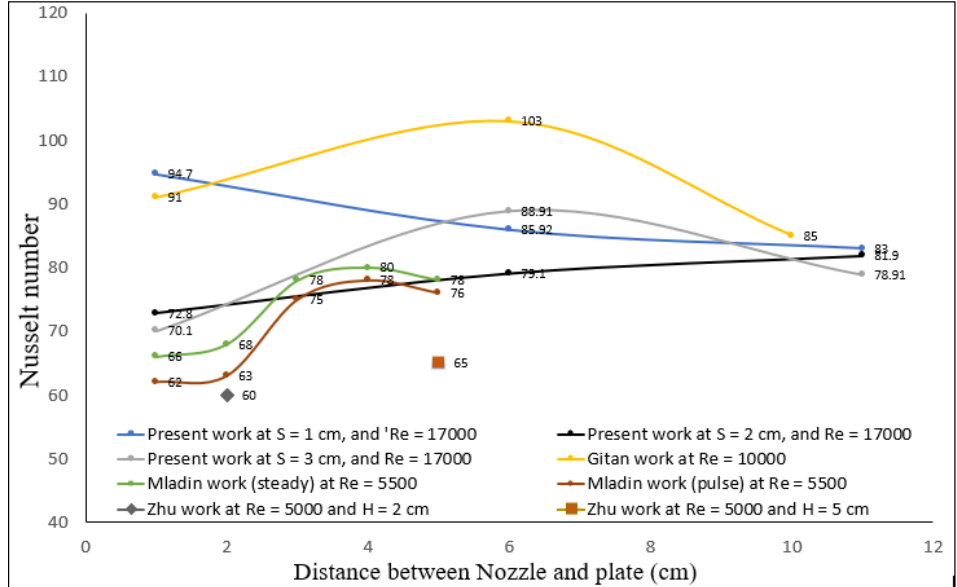
Figure 23. Interaction of nozzle-plate distance levels with Nusselt number values.